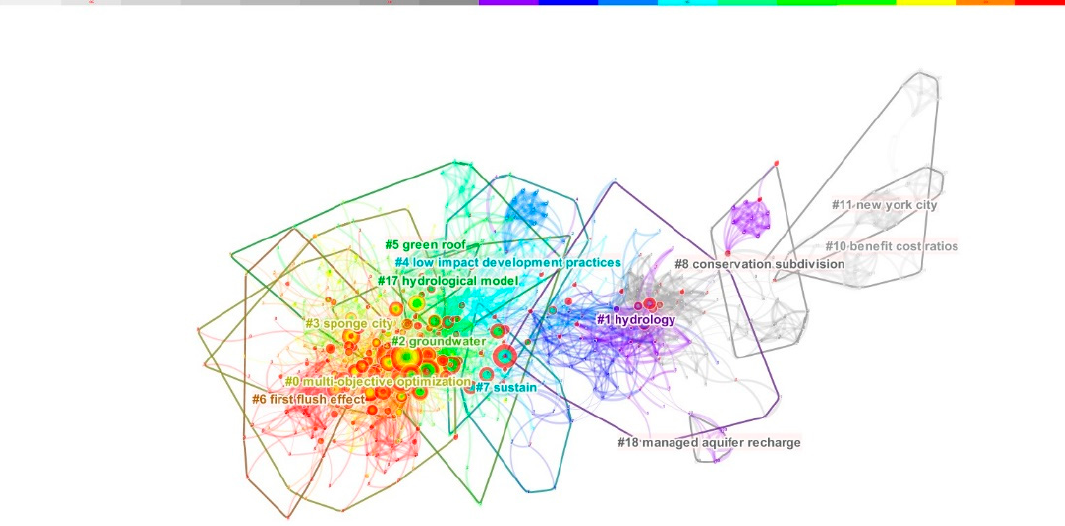
Figure 3. The co-citation references clustering network of the LID framework research based on the WOS.